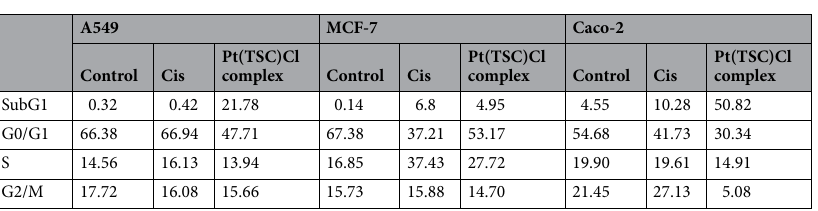
Table 6. Quantitative results of Cell cycle distribution of MCF-7, A549 and Caco-2 cells treated with the indicated IC 50 concentrations of cisplatin and Pt(TSC)Cl complex for 48 h determined by staining the DNA content of the cell followed by flow cytometry. The percentage of cells in G0/G1, S or G2/M phase is indicated. *Cis: Cisplatin, A549: Human lung cancer cells, Caco-2: Human colon cancer cells, MCF-7 Human breast cancer cells.